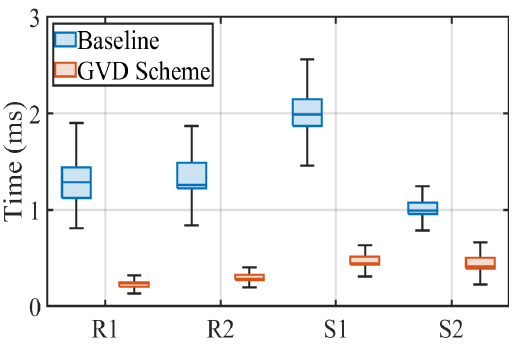
Figure 9. RoI extraction performance under variable LED shapes and